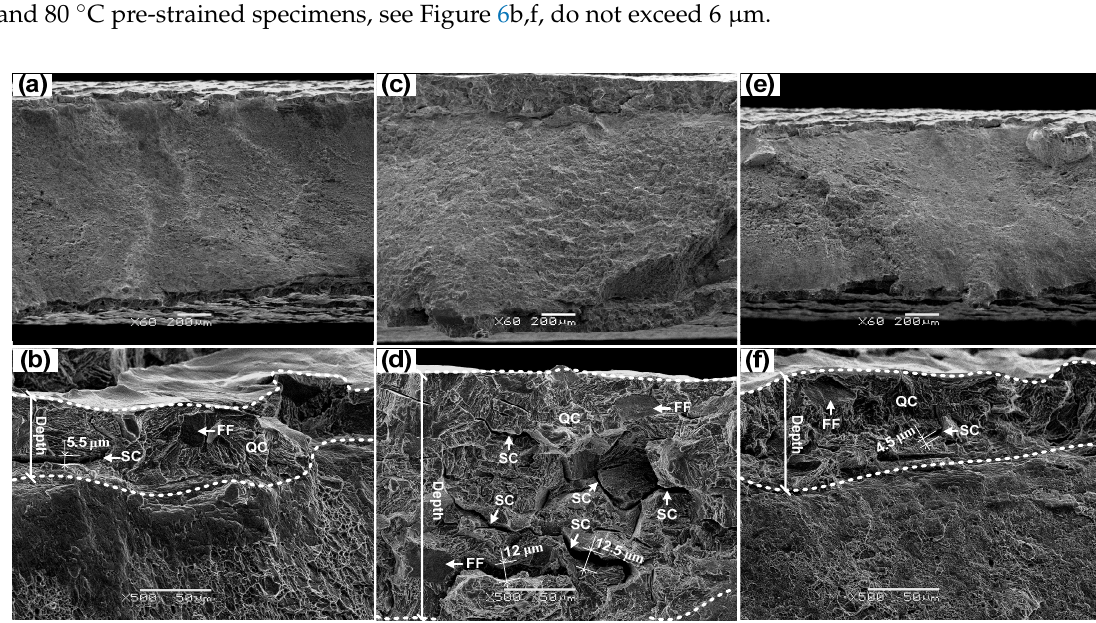
Figure 6. SEM fracture surfaces of broken specimens. ( a , b ) Un-pre-strained; ( c , d ) Pre-strained at 20 °C; ( e , f ) Pre-strained at 80 °C.